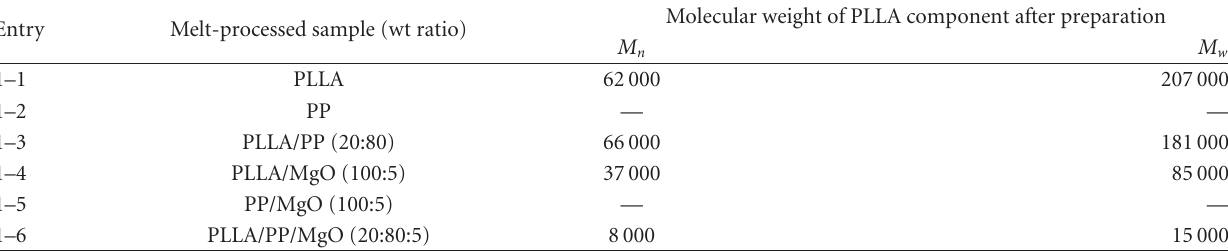
Table 1: Preparation of pellet samples with an extruder.